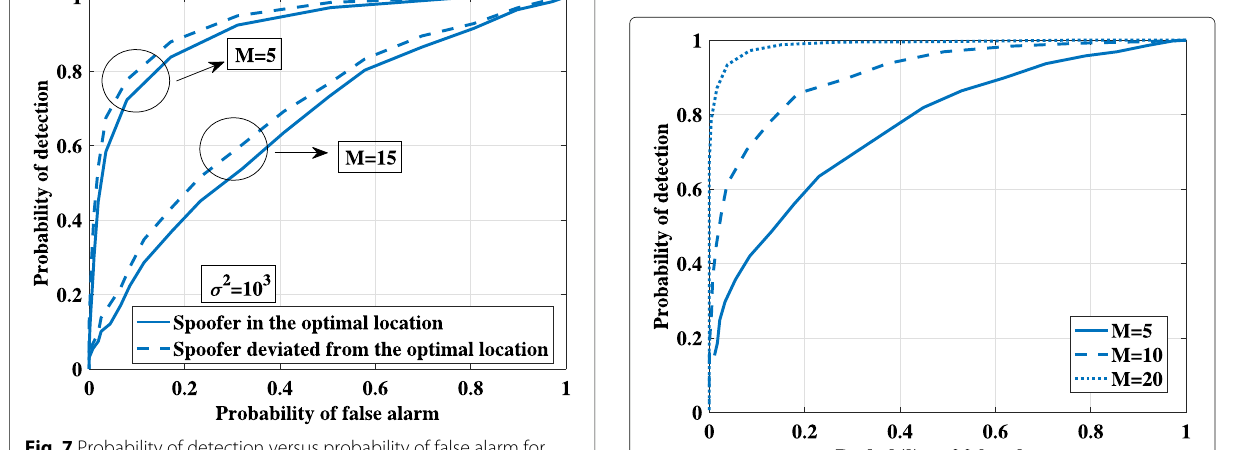
Fig. 7 Probability of detection versus probability of false alarm for N = I = 3 and b sp 0 = 10 3 × [0.5,0.5] when the spoofer locations A (cid:6) (cid:6) i (cid:6) (cid:6) deviate by 2 p p A i